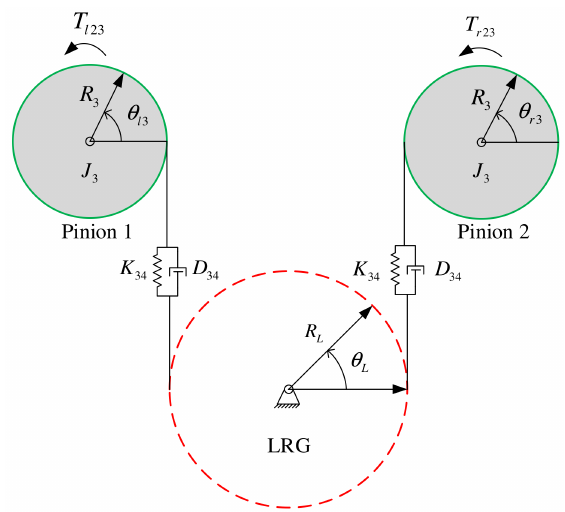
Figure 8. The dynamic model of meshing two pinions with the LGR.